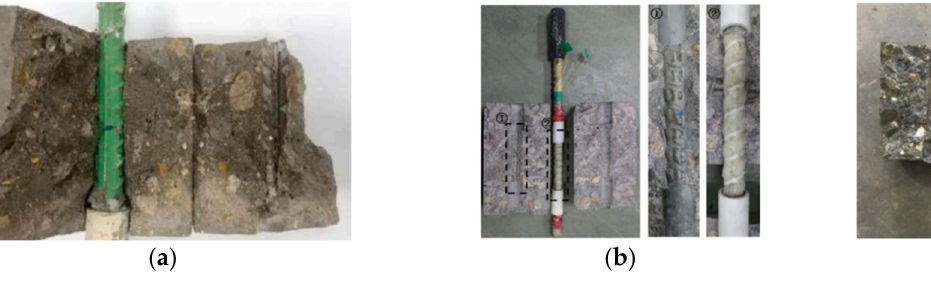
Figure 6. Bond strengths and bond strength retentions due to corrosion [39,94–96,98,102]. 4. Behavior after Corrosion 4.1. Corrosion Mechanism The corrosion mechanism can be classified according to material types, namely metal and nonmetal. For metal materials, oxidation is a common challenge. The metal can generate a passive film to prevent corrosion. The passive layer of black steel reinforcements (BSRs) is a submicroscopic (cid:2011) ‐ Fe 2 O 3 film [12,106]. However, it can be attacked by Cl ‐ [8,106–108]. The chloride ions can replace the oxygen ions [106–108], and the insoluble oxide is, thus, transmuted to soluble chlorine salt. After the passive film is damaged, the steel bar is electrochemically corroded. As shown in Figure 7a, the cathodic and anodic reactions occur simultaneously at the surface of BSRs where the steel matrix transfers the ions [8,109]. The iron atoms lose electrons to the anode. The ferrous ions combine with free hydroxide ions, which produces ferrous hydroxide. The ferrous hydroxide is further oxidized to ferric oxide, generally called rust [109]. In consequence, rust that is 2–10 larger than the passive product gathers on bars, which expands the concrete by a pressure of 3–4 MPa [16]. A crack thereby propagates from the bars to the surface of the concrete. In terms of galvanized reinforcements (GRs) and stainless cladding reinforcements (SCRs), either zinc or stainless steel can generate a more stable passive film than steel, which are Zn ‐ based and Cr ‐ based oxides, respectively. The